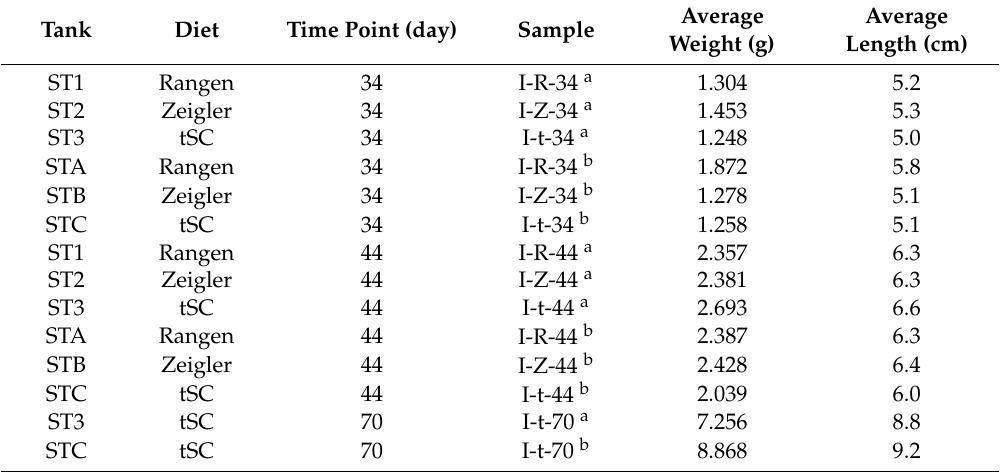
Table 1. Culture tank assignment, diet, time points, average length, and weight of shrimp sampled from the indoor production facility.